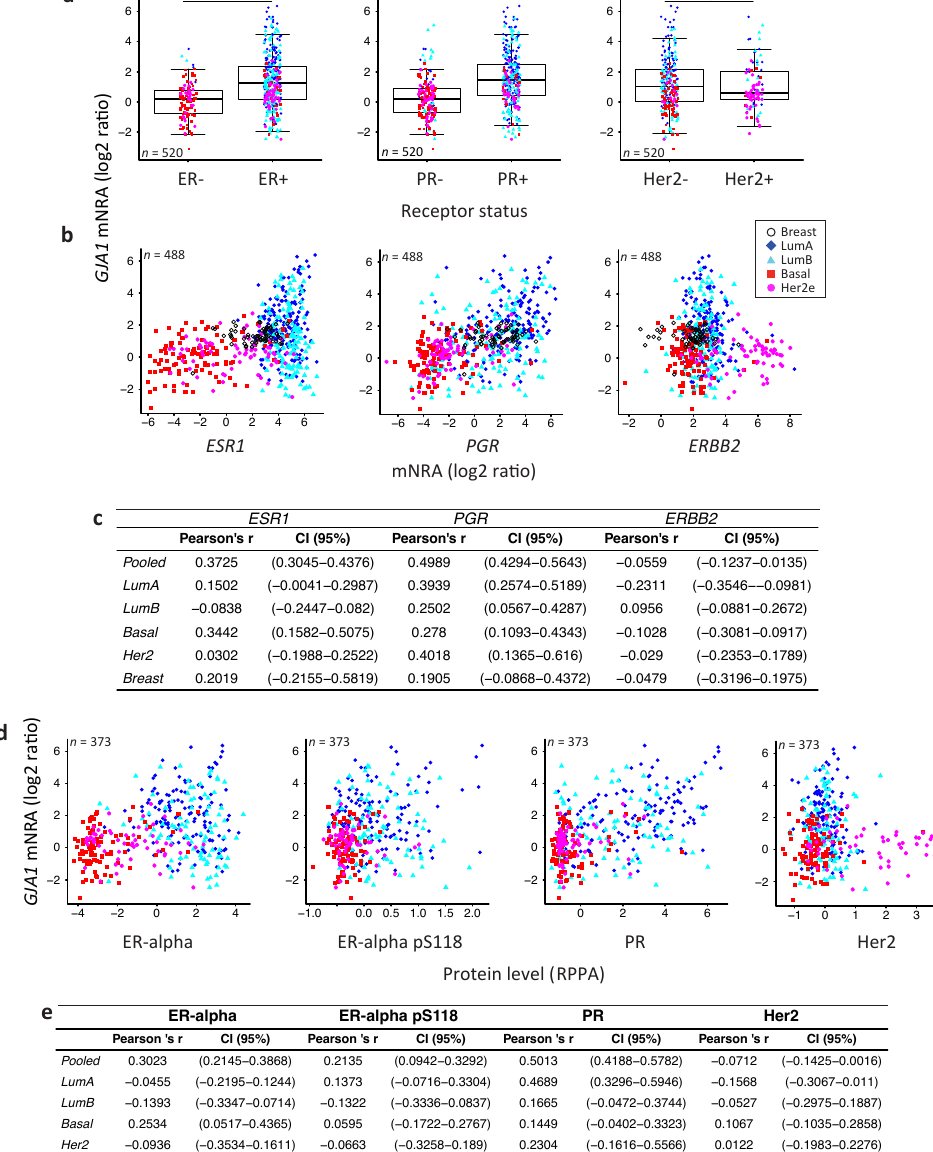
Figure 4. Depending on the receptor status, GJA1 is associated with different mRNA levels in clinical samples. ( a ) Expression of GJA1 mRNA stratified by estrogen receptor alpha (ER α ), progesterone receptor (PR) and erb-b2 receptor tyrosine kinase 2 (ERBB2/Her2) status in the TCGA dataset. p value: * <0.05; ** <0.01; *** <0.001; NS Not statistically significant. ( b ) Plot of GJA1 vs. ESR1 , PGR and ERBB2 mRNA (microarray) level in each subtype and in normal breast tissue. In the legend, “Breast” indicates adjacent normal breast tissue. ( c ) Bootstrapped correlations between ESR1 , PGR or ERBB2 and GJA1 mRNA level either in pooled breast cancer tumors or in individual breast cancer intrinsic subtypes and in normal breast tissue. ( d ) Plot of GJA1 mRNA vs. ER-alpha, ER-alpha pS118, PR or HER2 protein level assessed by reverse phase protein assay (RPPA). ( e ) Bootstrapped correlations between GJA1 mRNA and ER-alpha, ER-alpha pS118, PR or HER2 protein level (RPPA). All data are from TCGA’s BRCA